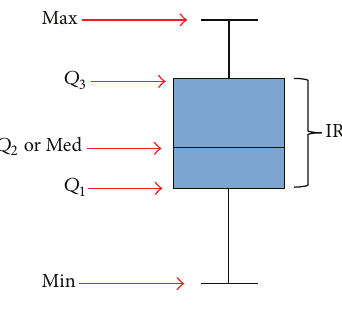
Figure 3: A general box plot.